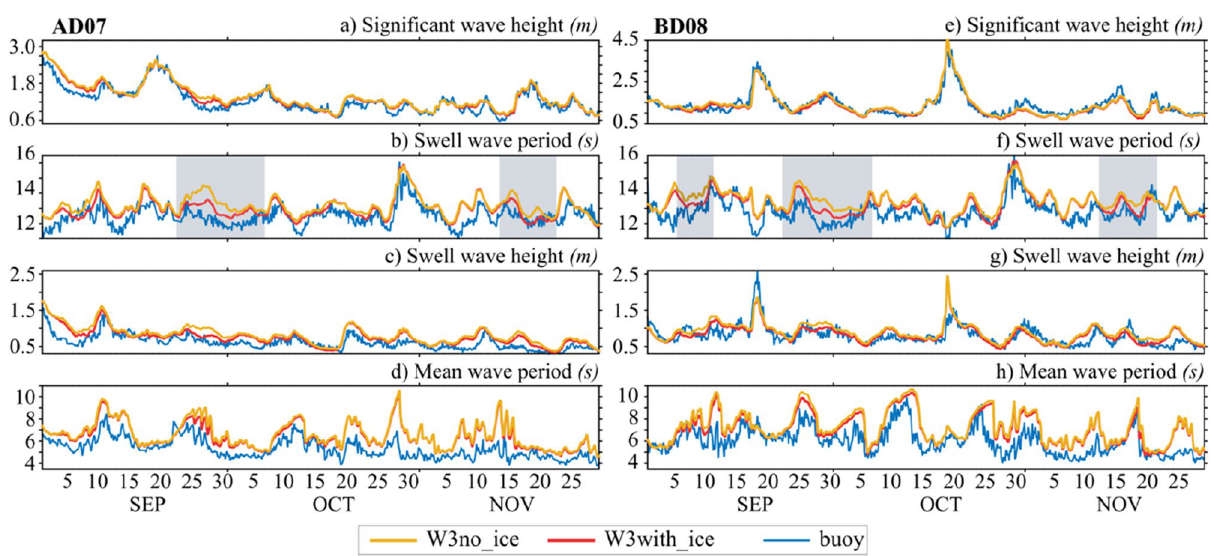
Figure 4. Time series comparison of W3 no_ice (orange) and W3 with_ice (red) with mooring data (blue) for ( a , e ) significant wave height, Hs, ( b , f ) swell wave period, Tm, ( c , g ) swell wave height, HsS and ( d , h ) mean wave period, Tm at AD07 (right panels) and BD08 (left panels) for